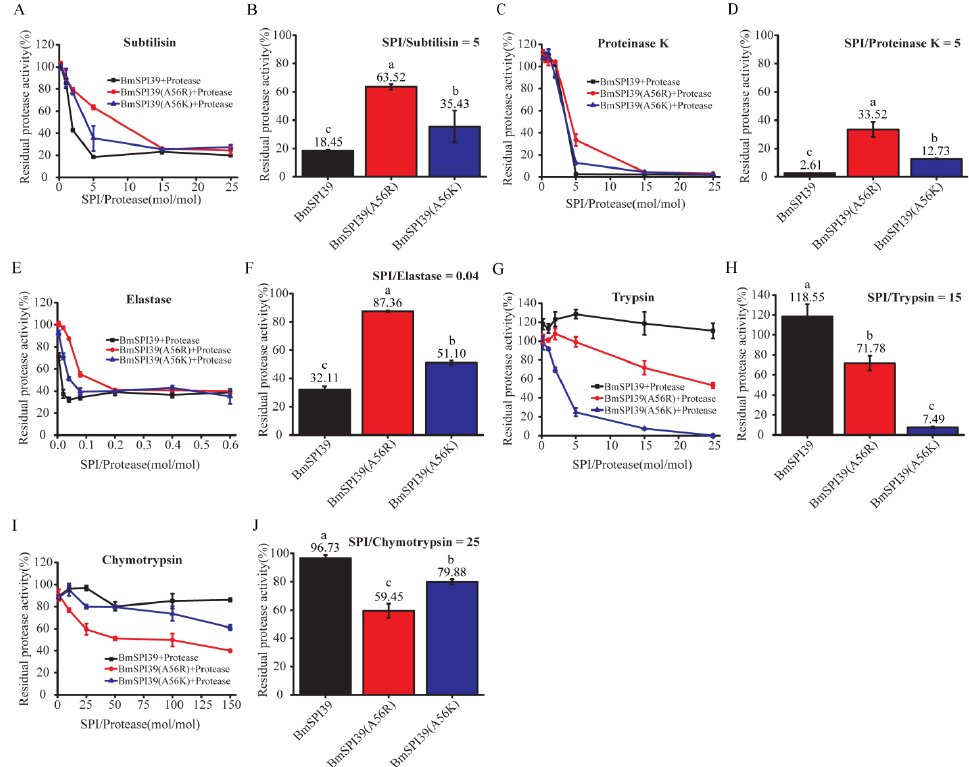
Figure 7. Comparison of the inhibitory ability of mutant BmSPI39 proteins to different serine proteases. Inhibitory effects of increasing concentrations of mutant BmSPI39 proteins against subtilisin ( A ), proteinase K ( C ), elastase ( E ), trypsin ( G ), and chymotrypsin ( I ), respectively. The inhibitory activities of the mutant BmSPI39 proteins against subtilisin ( B ), proteinase K ( D ), elastase ( F ), trypsin ( H ), and chymotrypsin ( J ) at the indicated molar ratio of inhibitor and protease. Error bars represent the standard error of the mean ( n = 3). Different letters “a–c” indicate a significant difference between groups ( p < 0.05), and one identical letter indicates no significant difference between groups ( p < 0.05).